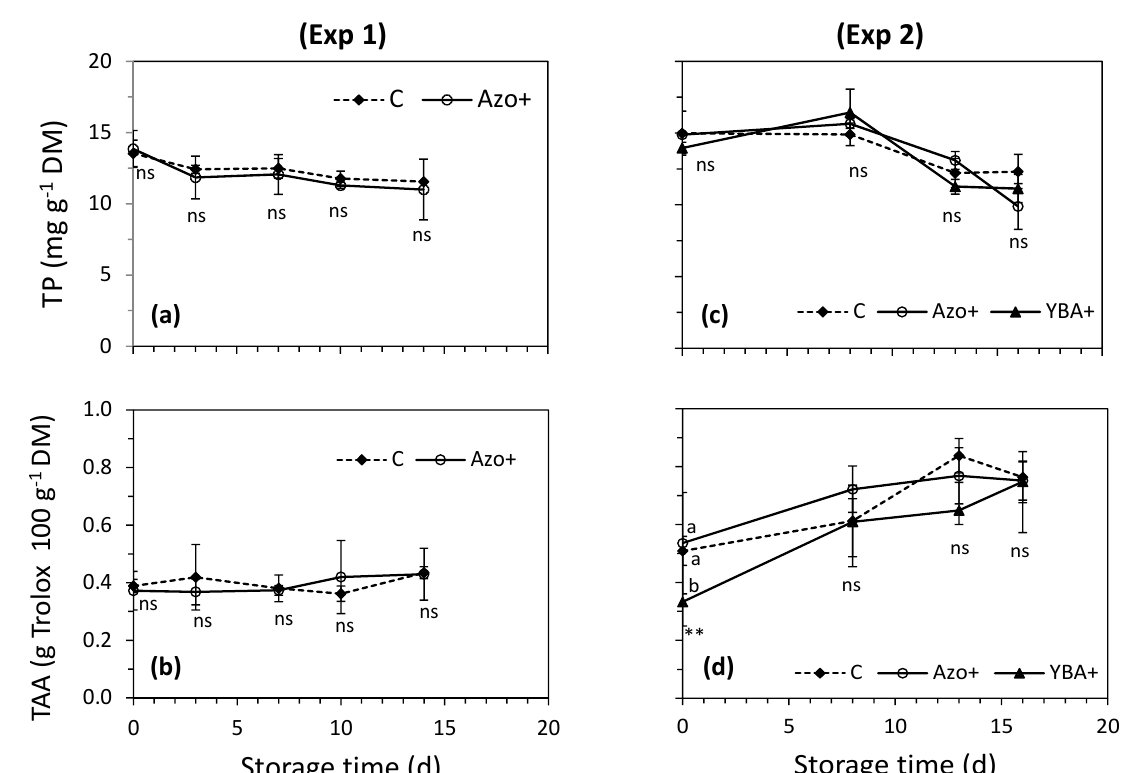
Figure 4. Trend of the nitrate content (Ni), total phenols (TP) and antioxidant activity (TAA) during the storage of the wild rocket ( a , b ) and with Azoxystrobin or an algae-based biostimulant (YBA+) in Exp 2 ( c , d ), and of that relating to the untreated control (C). DM = dry matter. Vertical bars indicate SD (n = 3). ns, ** indicate F test not significant, significant at P ≤ 0.05 and significant at P ≤ 0.01, respectively. Separation of mean within the days from the start of storage by SNK test ( P = 0.05). Different lower case letter denotes significant differences.